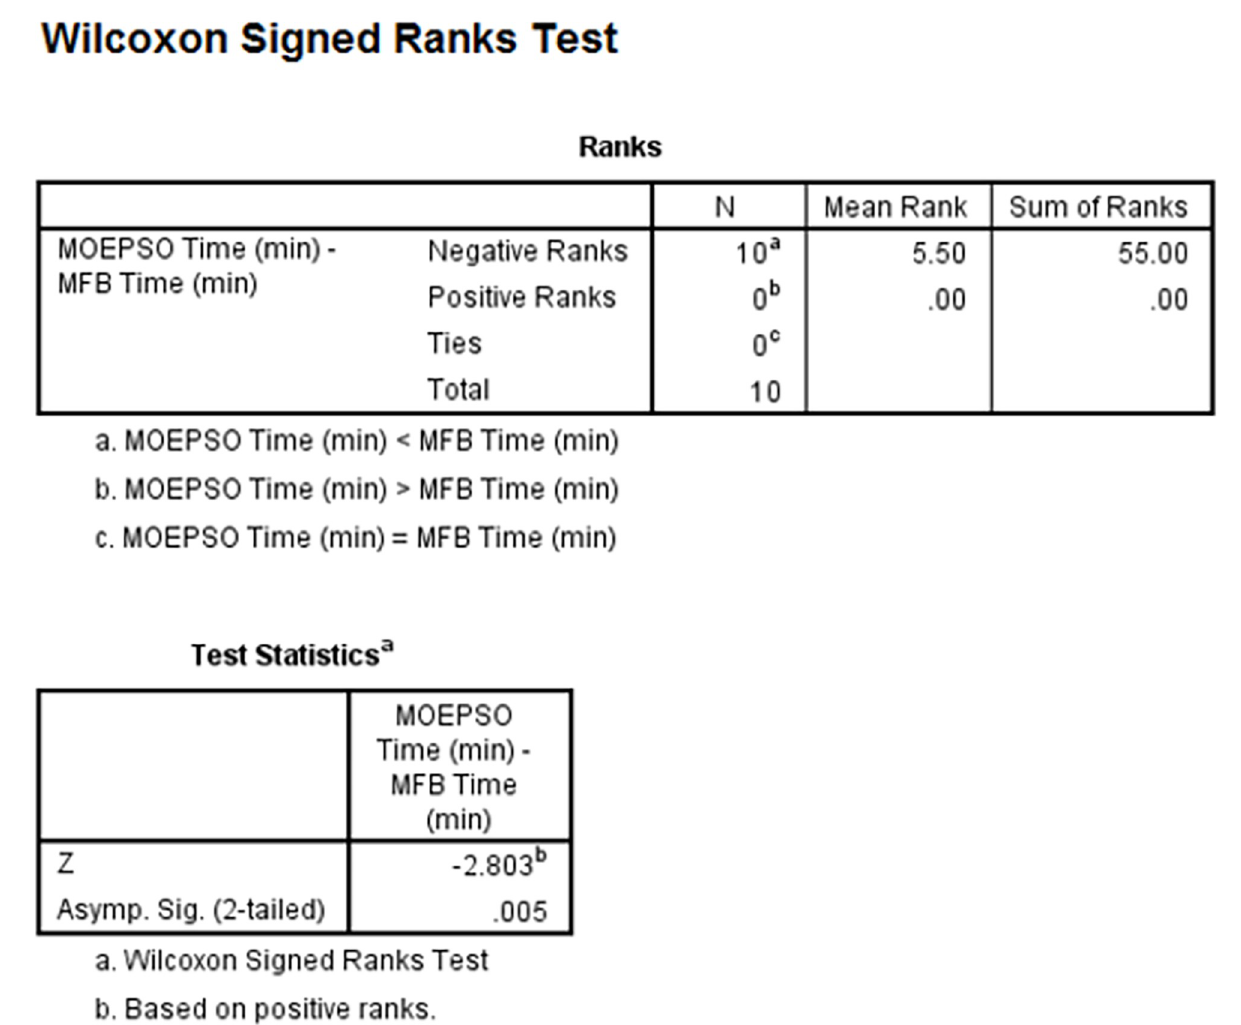
Fig 24. Wilcoxon signed-rank test processing time of MOEPSO-processing time of